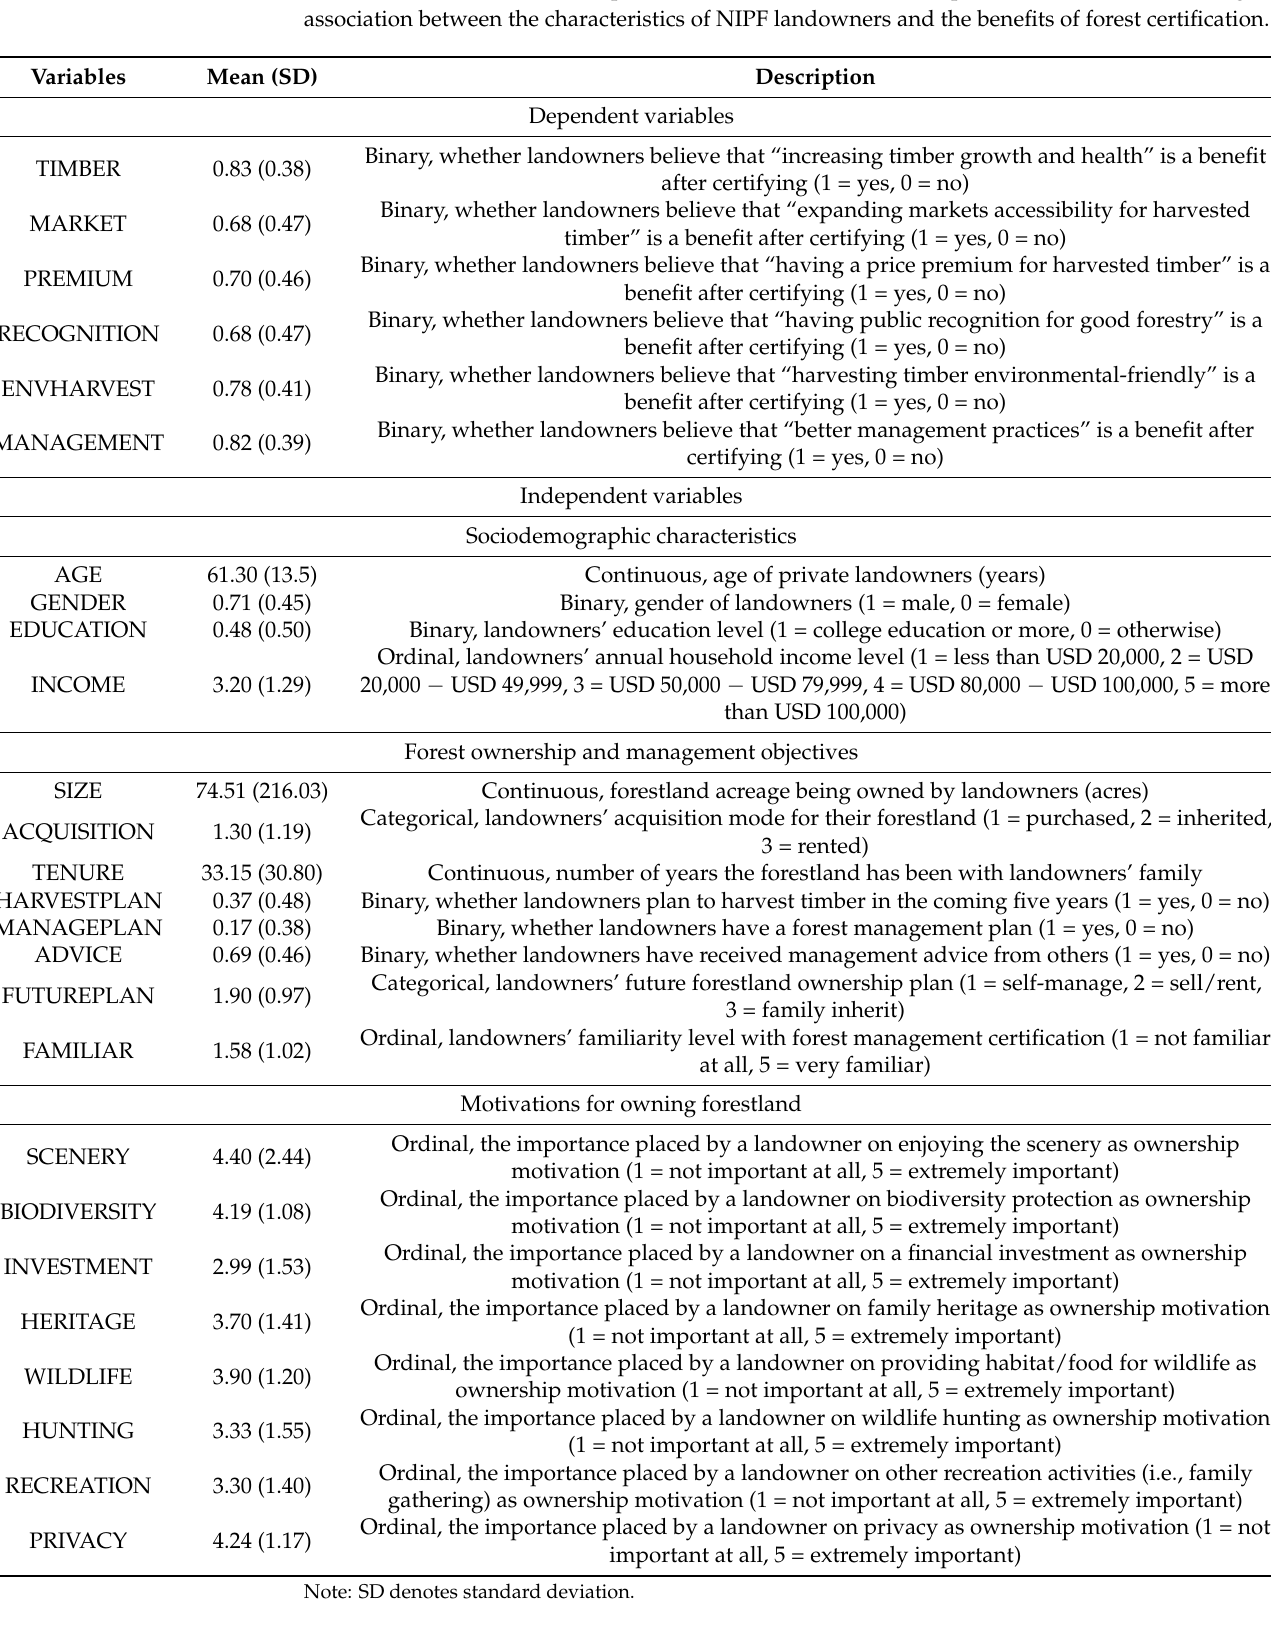
Table 1. Definition and description of variables used in the empirical models for estimating the association between the characteristics of NIPF landowners and the benefits of forest